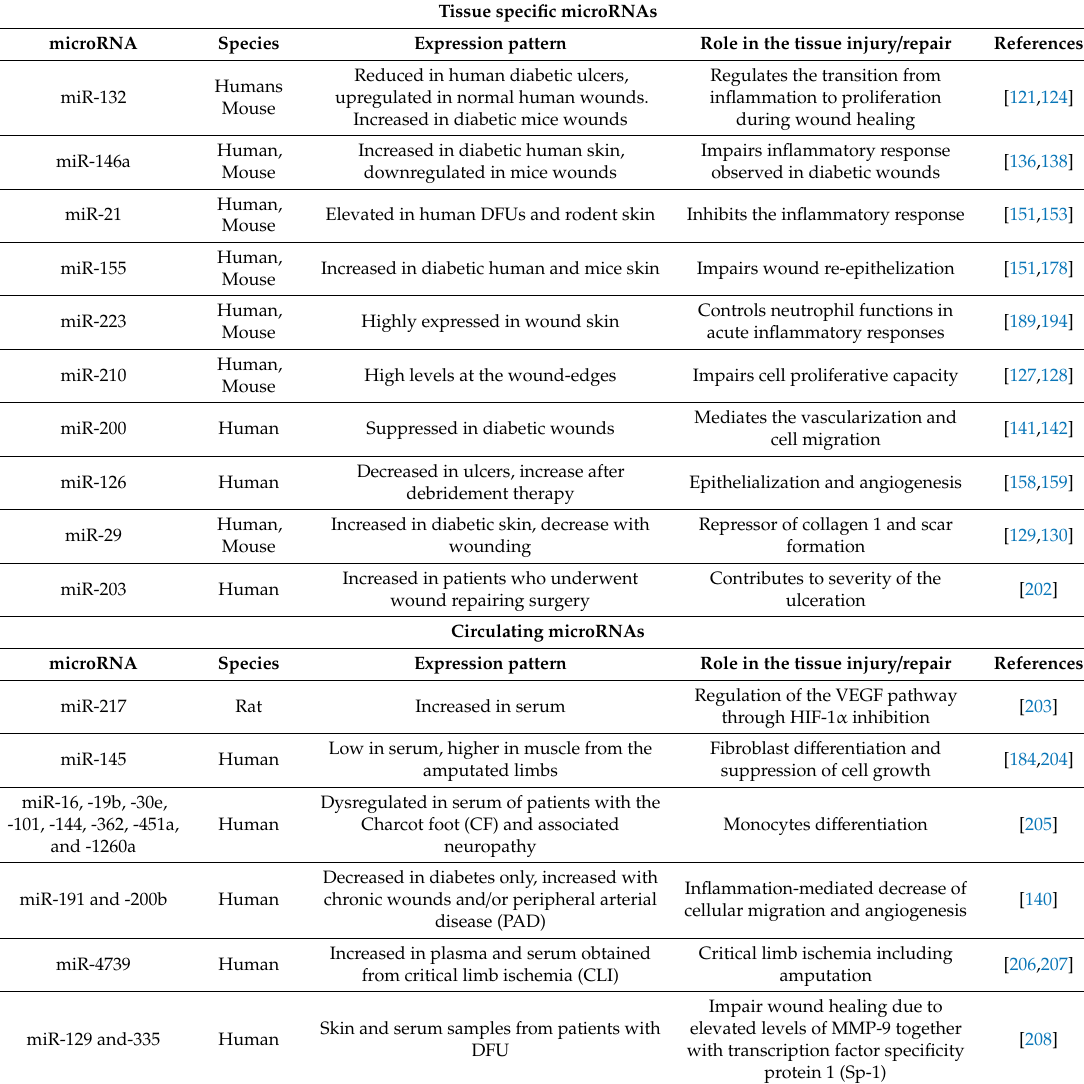
Table3. Tissueand circulatingmicroRNAsthat occurin diabetic tissue, some ofthem are